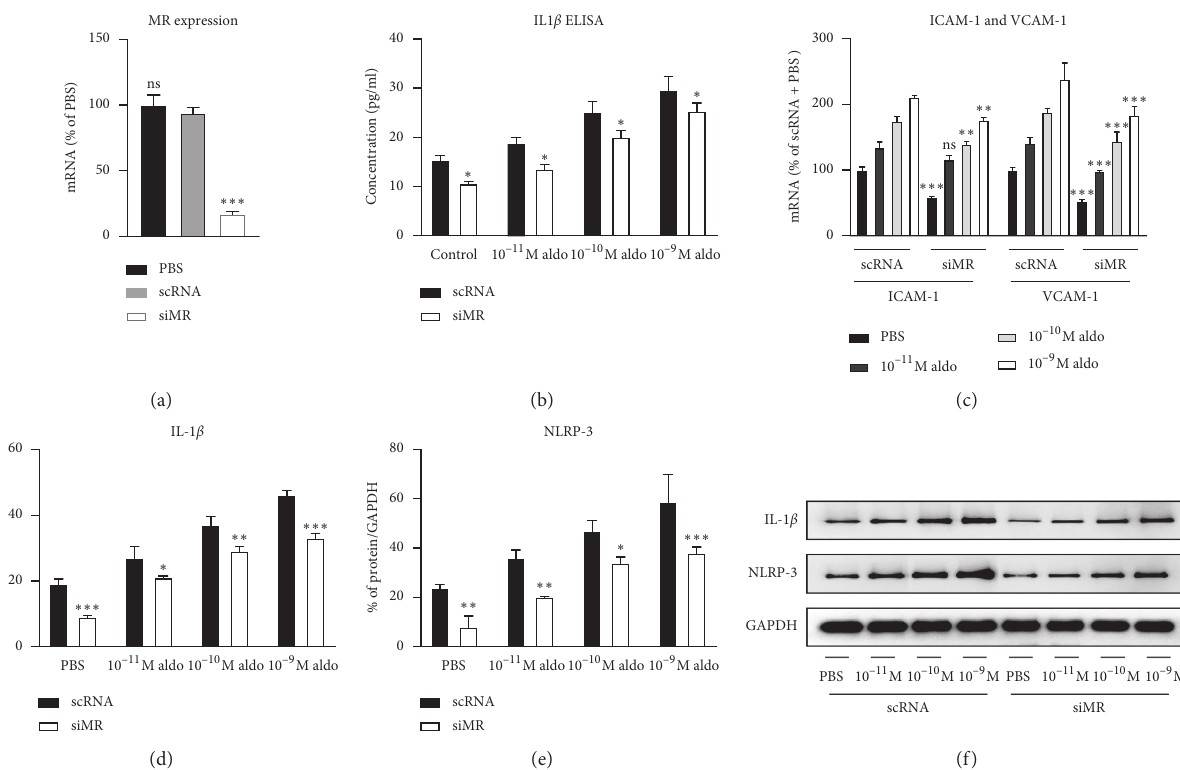
Figure 1: Inflammatory response before and after MR knockdown with different aldosterone concentrations. (a) MR mRNA expression; (b) level of cell culture medium IL-1 β ; (c) ICAM-1 and VCAM-1 mRNA expressions; (d) protein level of IL-1 β ; (e) protein level of NLRP-3; (f) Western blot of IL-1 β and NLRP-3. scRNA: the state with control RNA, siMR: the state after MR knockdown, aldo: aldosterone. ∗ p value < 0.05 compared between scRNA and siMR with the same aldosterone concentration, ∗∗ p value < 0.01 compared between scRNA and siMR with the same aldosterone concentration, ∗∗∗ p value < 0.001 compared between scRNA and siMR with the same aldosterone concentration. ns: